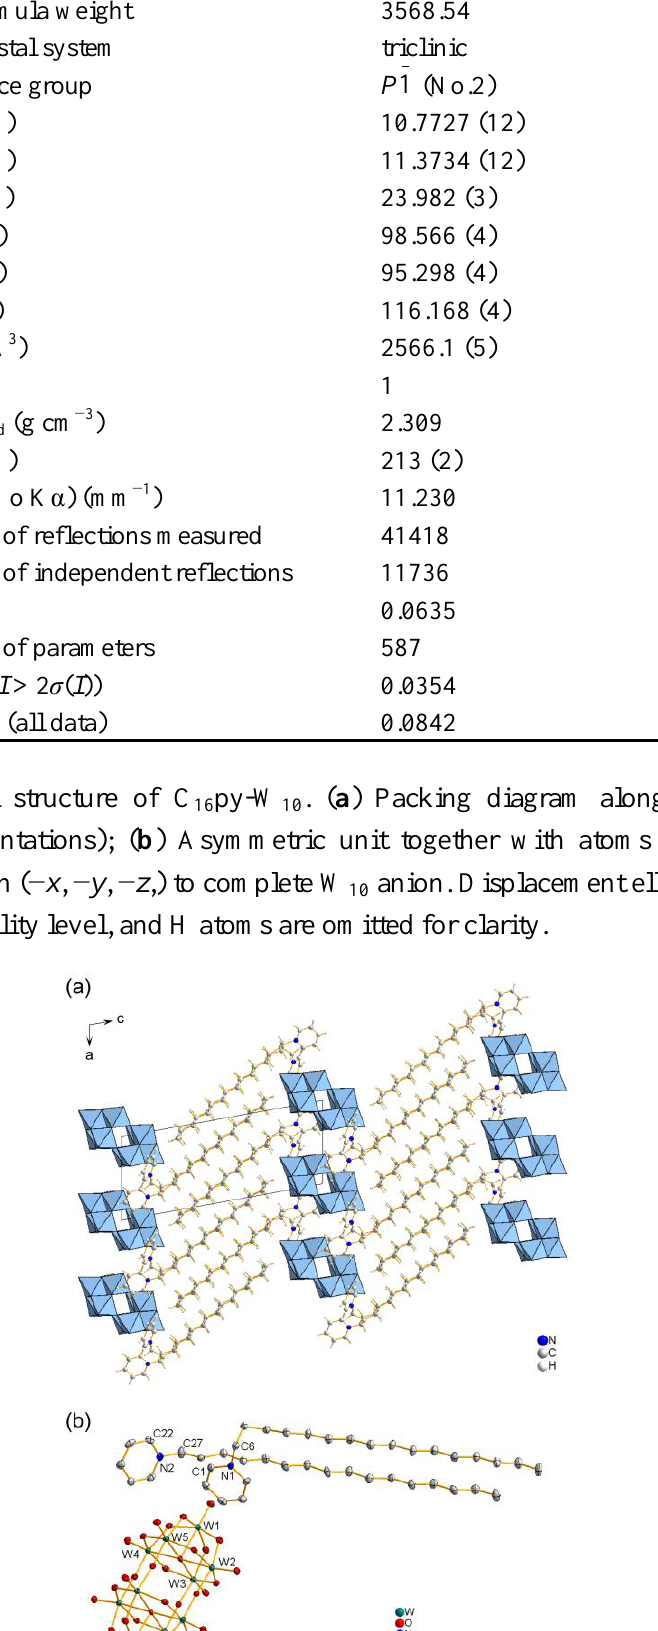
Table 1. Crystallographic data for C